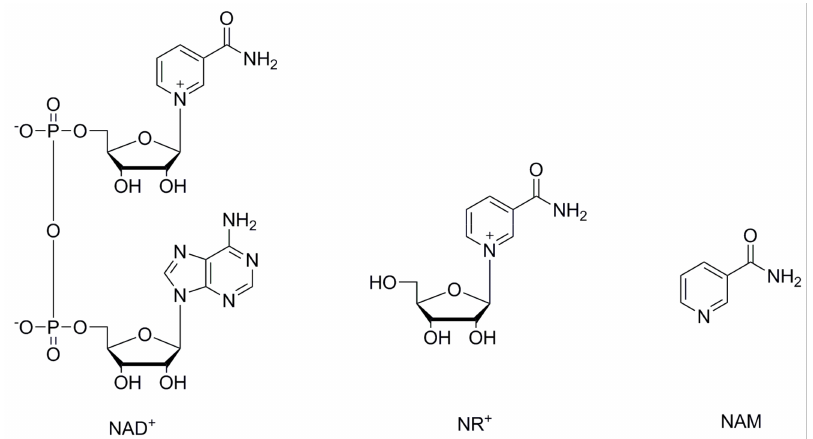
Figure 1. Structures of NAD + , NR + and